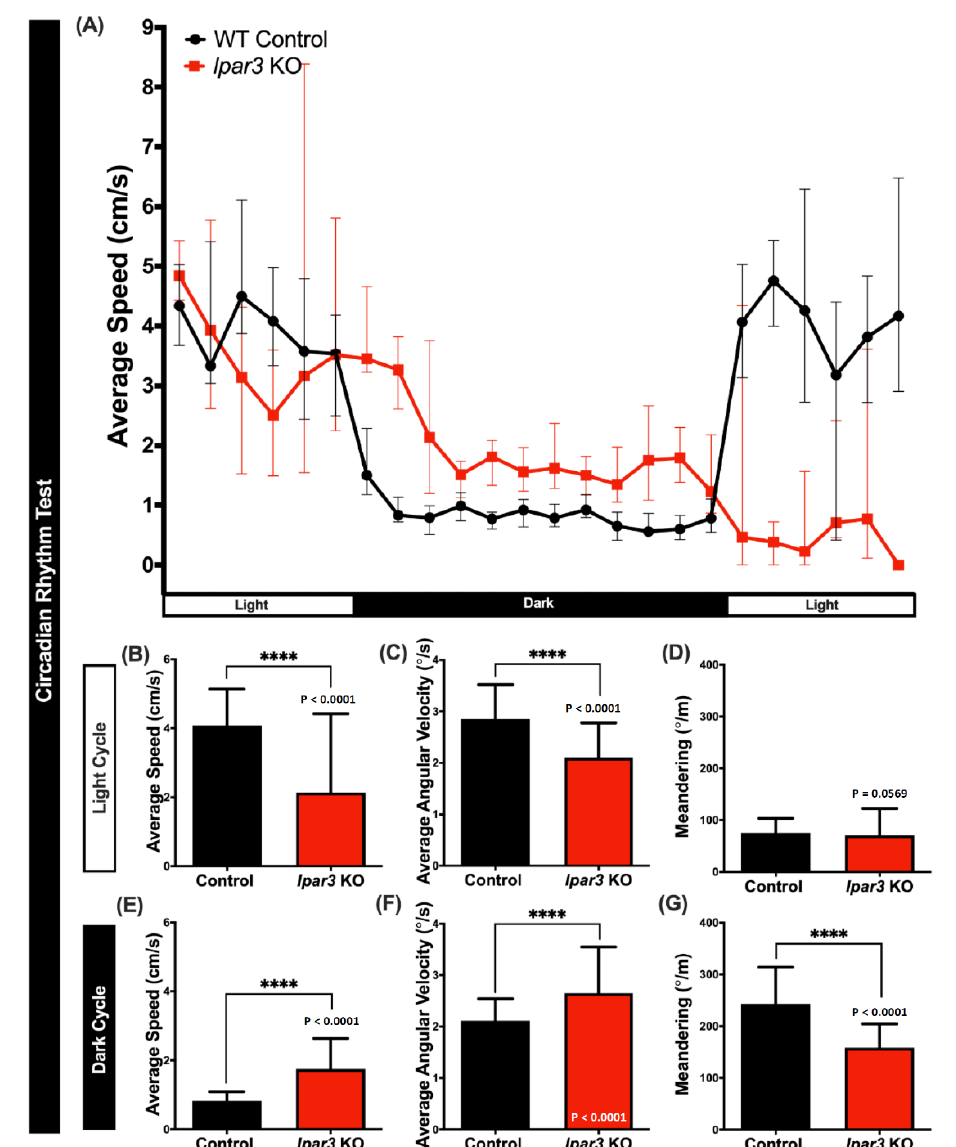
Figure 5. Comparison of behavior endpoints between wild-type (black) and lpar3 KO (red) fish in the circadian rhythm locomotor activity assay. ( A ) Comparison of chronological changes of the average speed in light and dark cycles. Comparison of the average speed ( B ), average angular velocity ( C ), and meandering ( D ) between wild-types and lpar3 KO fish in the light cycle. Comparison of the average speed ( E ), average angular velocity ( F ), and meandering ( G ) between wild-type and lpar3 KO fish during the dark cycle. The data are expressed as the median with interquartile range and were analyzed by the nonparametric Mann–Whitney test ( n = 18 for control; n = 16 for lpar3 KO fish; **** p < 0.0001).